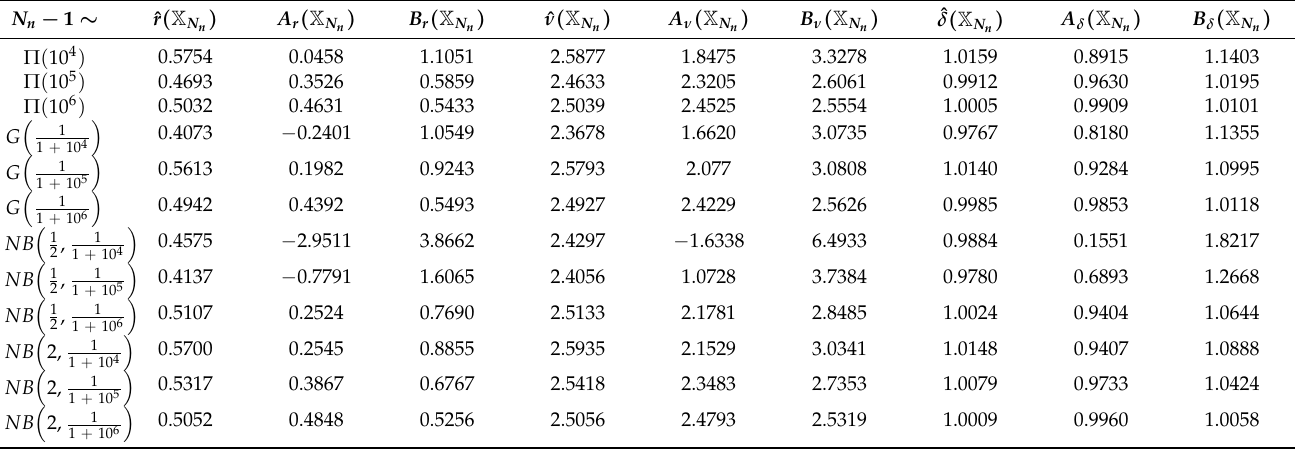
Table 2. Examples of parameter estimates and boundaries of confidence intervals for a model distribution for r = 0.5, ν = 2.5, and δ =